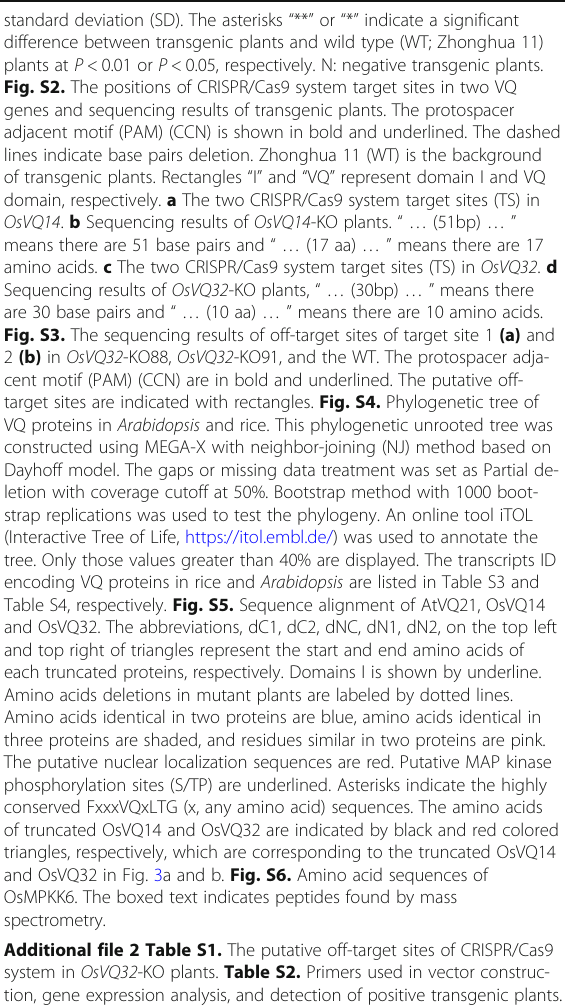
standard deviation (SD). The asterisks “ ** ” or “ * ” indicate a significant difference between transgenic plants and wild type (WT; Zhonghua 11) plants at P < 0.01 or P <0.05, respectively. N: negative transgenic plants. Fig. S2. The positions of CRISPR/Cas9 system target sites in two VQ genes and sequencing results of transgenic plants. The protospacer adjacent motif (PAM) (CCN) is shown in bold and underlined. The dashed lines indicate base pairs deletion. Zhonghua 11 (WT) is the background of transgenic plants. Rectangles “ I ” and “ VQ ” represent domain I and VQ domain, respectively. a The two CRISPR/Cas9 system target sites (TS) in OsVQ14 . b Sequencing results of OsVQ14 -KO plants. “ … (51bp) … ” means there are 51 base pairs and “ … (17 aa) … ” means there are 17 amino acids. c The two CRISPR/Cas9 system target sites (TS) in OsVQ32 . d